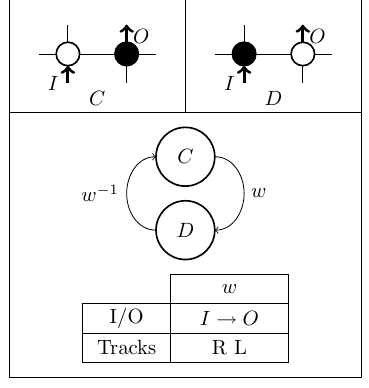
Figure 8. Straight PATH.